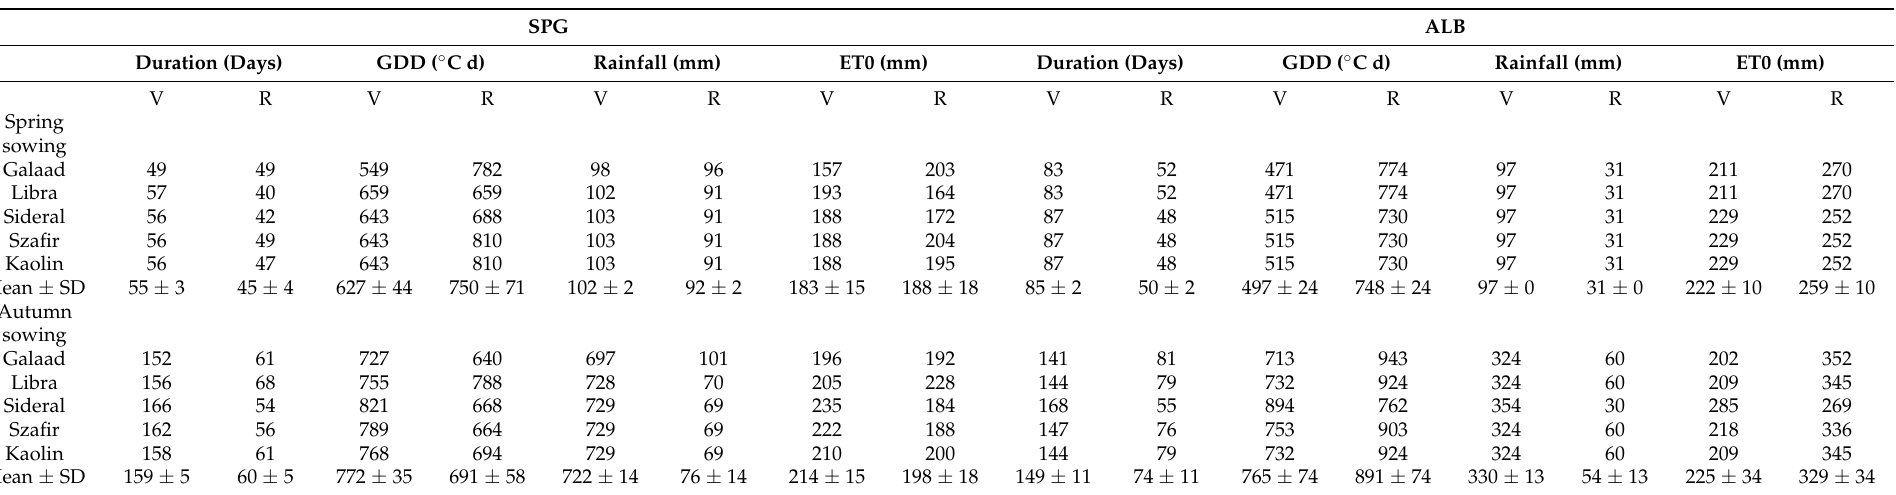
Table 2. Duration, growing degree days (GDD), cumulative rainfall (mm) and ET0 (mm) evaluated during vegetative (V—from sowing to beginning of flowering) and reproductive (R—from beginning of flowering to maturity) cycles of five linseed varieties in spring (2020) and autumn (2021)